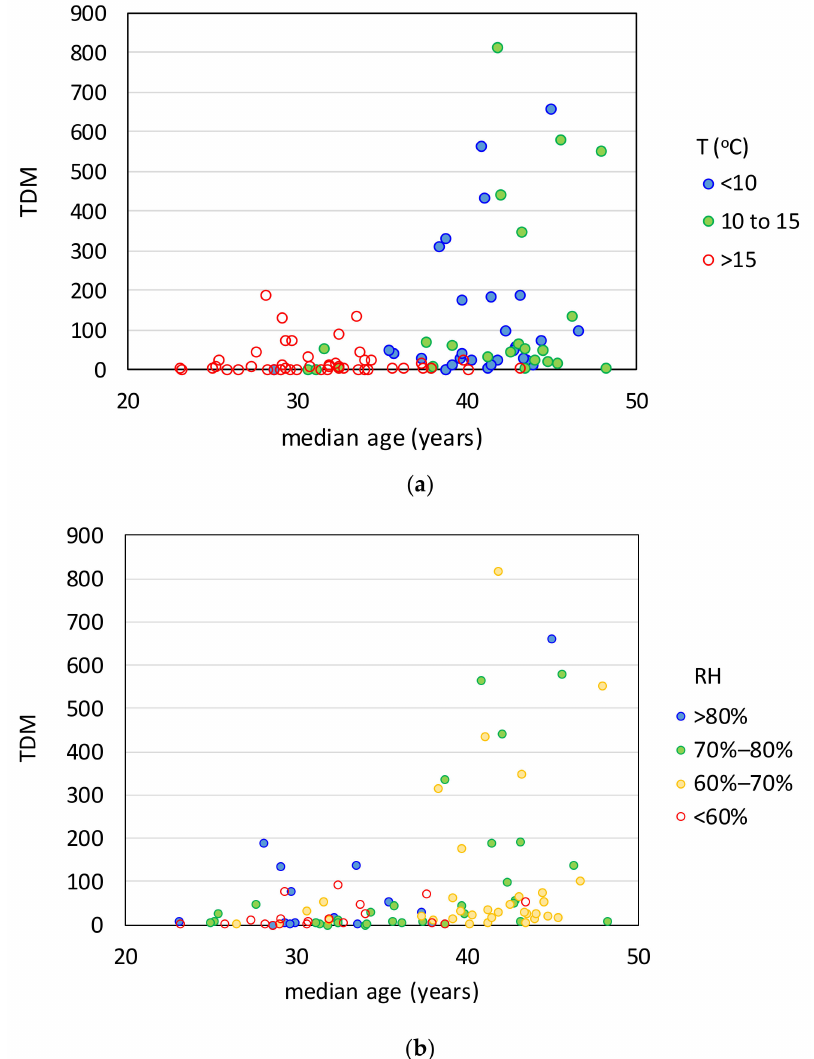
Figure 12. Total deaths per million as function of the population median age for di ff erent ranges of ( a ) temperature and ( b ) relative humidity (HDI >